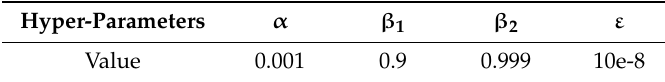
Figure 6. Training curves of different network models. Table 3. Training-relevant hyper-parameters.